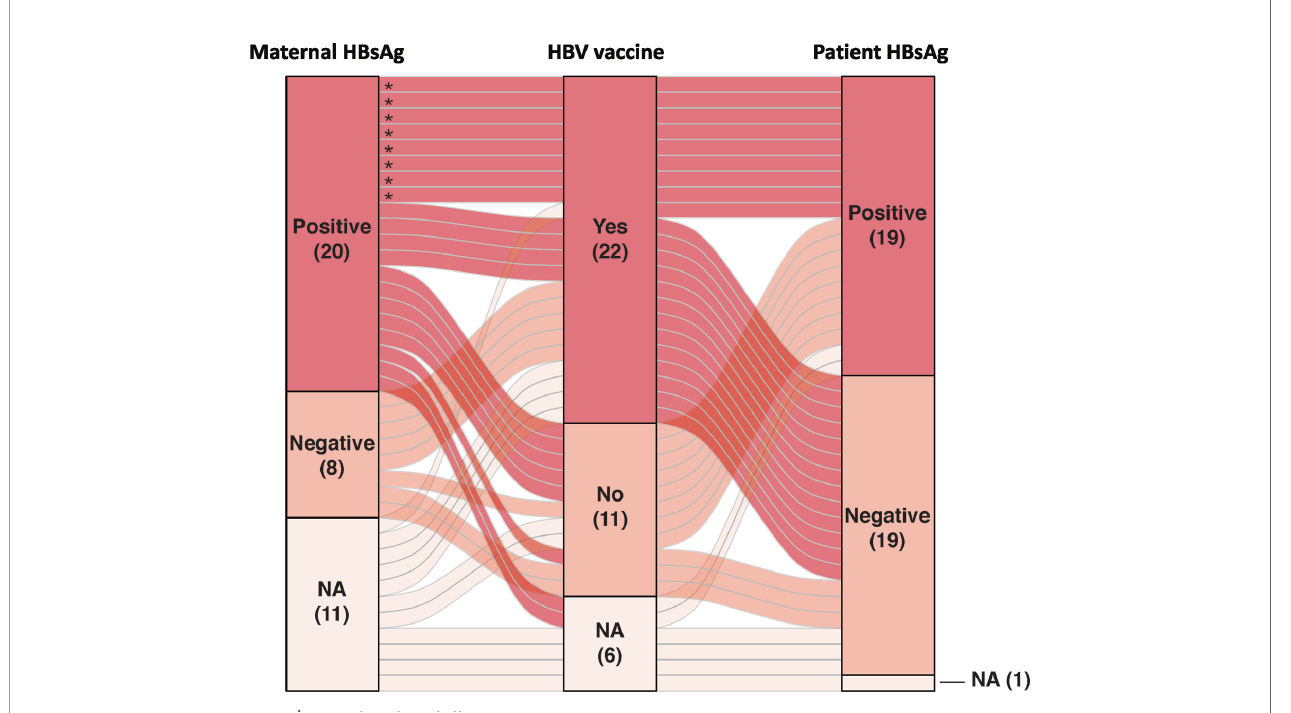
FIGURE 1 | Alluvial plot depicting the patients ’ hepatitis B virus (HBV) serology, maternal HBV serology, and HBV vaccination status in our cohort (* patients with vaccine failure). HBsAg, hepatitis B surface antigen; NA, not available.